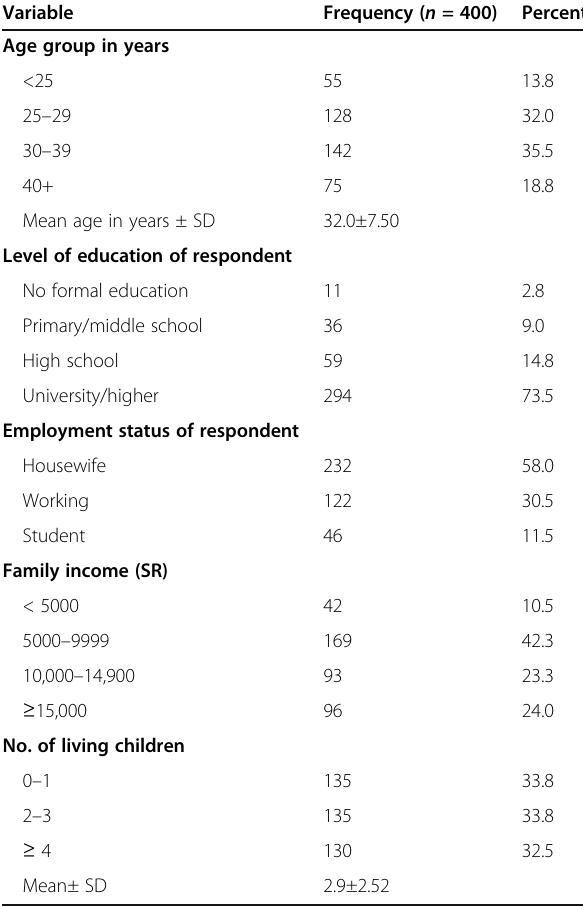
Table 1. Most participants received university education (294, 73.5%). More than half (211, 52.8%) of the partici- pants reported family income <10,000 SR, while those who reported high income ≥ 15,000 SR were 96 (24.0%). The mean living children per woman was 2.9±2.5 children, with about one-third (130, 32.5%) had more than 3 children (Table 1). Table 1 Sociodemographic characteristics of